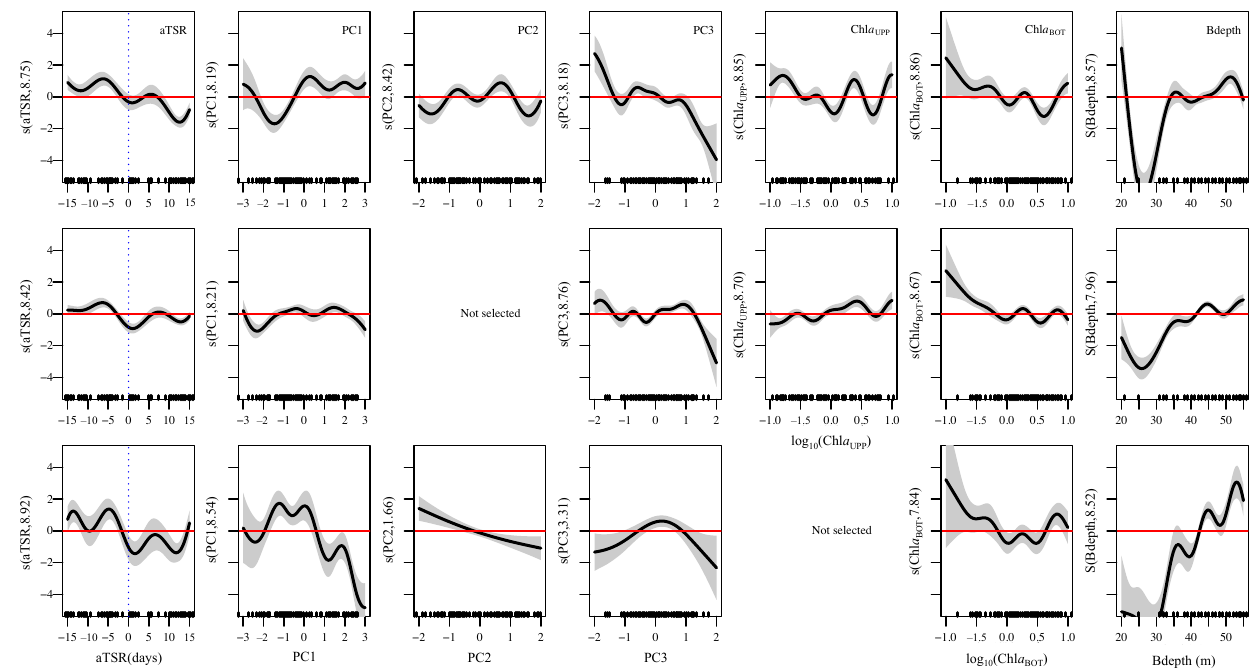
Figure 5. GAM plot of the best model in each copepod groups: large Arctic (CopL arc ) , small Arctic (CopS arc ) and Pacific (Cop pac ) copepods. The horizontal axes show the explanatory variable: the anomaly of the timing of sea ice retreat (aTSR), principal component score (PC1–3) averaged log-transformed chlorophyll a concentration within the layer above and below pycnocline, (Chl a UPP and Chl a BOT ) and bottom depth (Bdepth). Shade area represents 95% confidence intervals. The vertical axes indicate the estimate smoother for the abundance of copepods. The estimated smoother converts the explanatory variable to fit the models, so it shows positive effects for response variables and the magnitude of its effects when estimated smoother is positive and vice versa. Short vertical lines located on the x axes of each plot indicate the values at which observations were